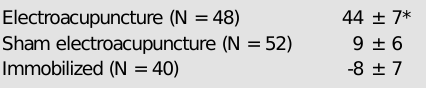
Table 1. Change in root mean square of the myo- electric activity recorded in the proximal 1/3 of the small intestine at four different locations for each of the three experimental groups (electroacupunc- ture, sham electroacupuncture and immobilized) compared to the baseline condition (control re-